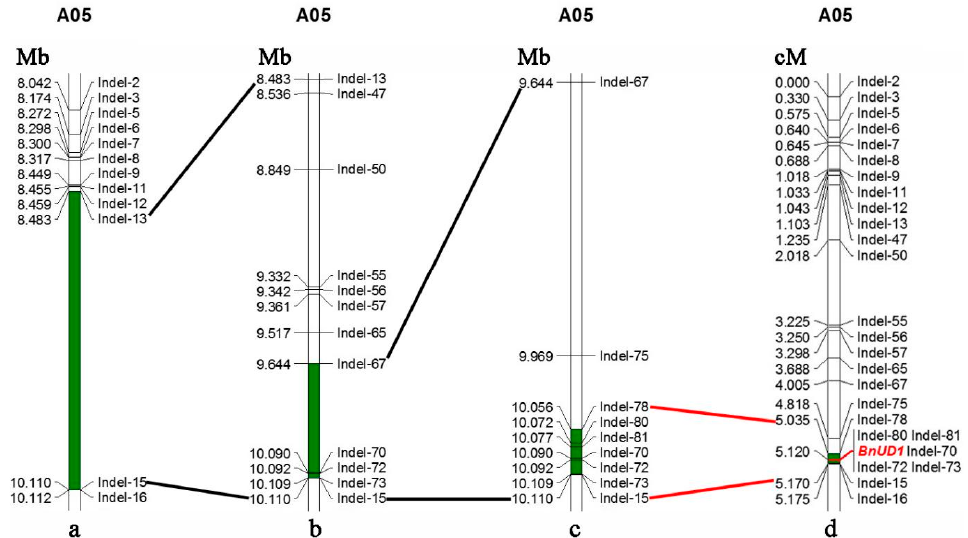
Figure 2. Mapping the leaf up-curling and silique downward-pointing locus BnUD1 . ( a ) indicates that the BnUD1 locus was preliminary mapped in an interval of 1.63 Mb (shaded in green) between InDel markers InDel-13 and Indel-15 (black lines) on A05 chromosome. ( b ) shows that the BnUD1 locus was blue-colored in the physical interval of 466.58 kb (shaded in green) with facilitation of the developed InDel markers. ( c ) shows that the BnUD1 locus was fine mapped in the physical interval of 54.84 kb (shaded in green). ( d) shows that BnUD1 was in a 0.135 cM region between InDel markers Indel-78 and Indel-15 (red lines), shaded in green. The BnUD1 locus is highlighted in red.